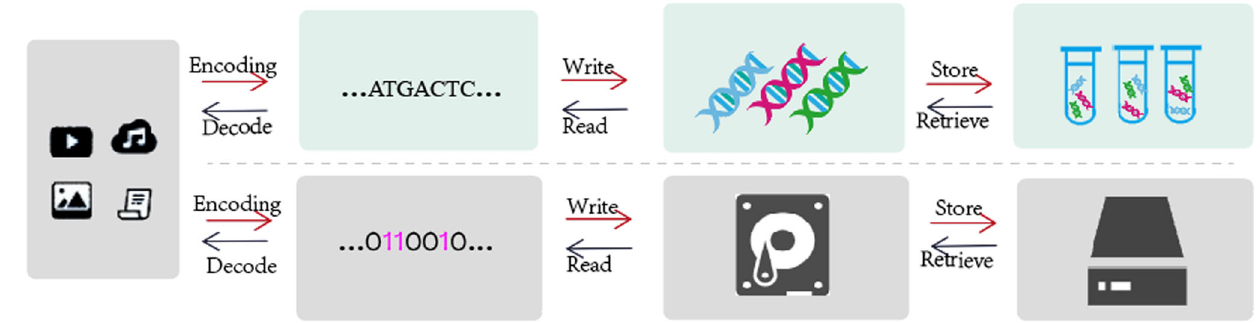
Fig. 1 DNA storage versus conventional magnetic